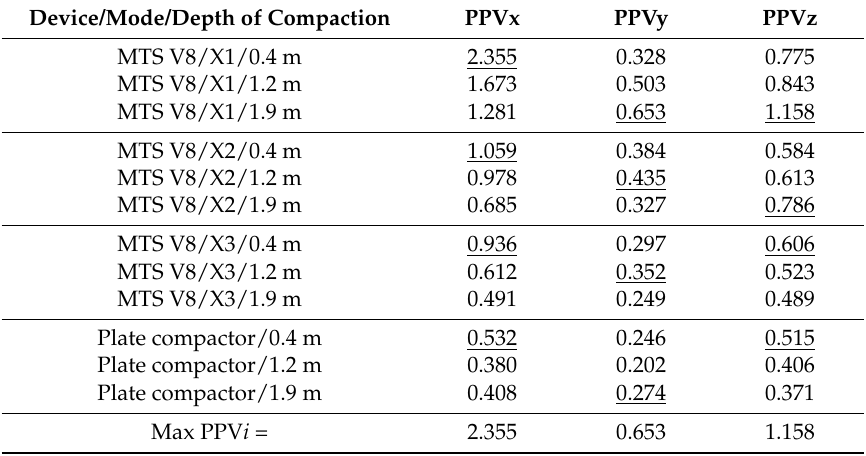
Table 7. Peak component particle velocities at the foundation wall of the building—stage III,